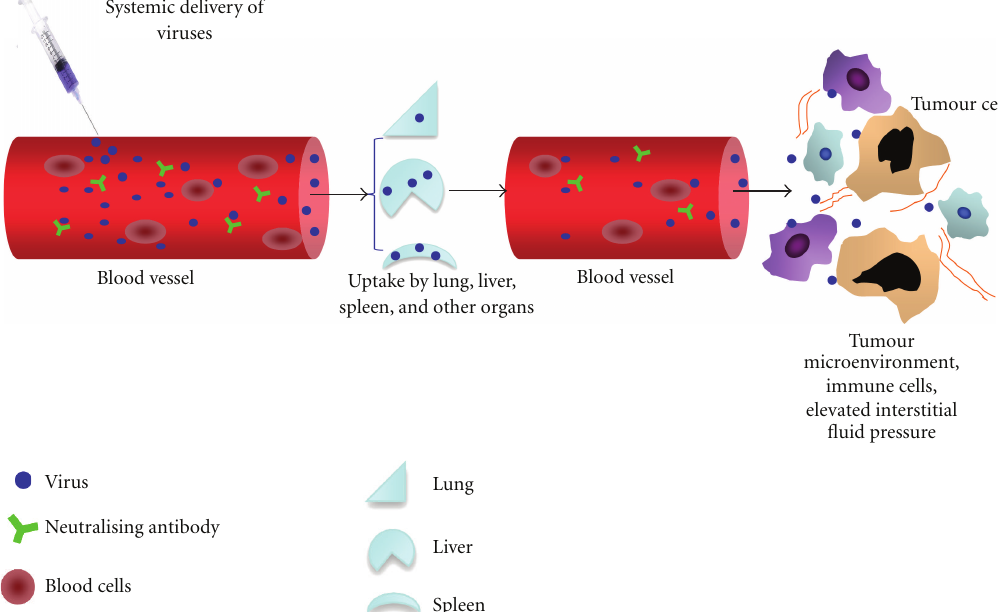
Figure 1: Hurdles of systemic delivery of oncolytic viruses to tumour cells. After intravenous injection, viruses are neutralised by pre- existing antibodies and complement activation. Oncolytic viruses also interact with blood cells. Sequestration into other organs and the reticuloendothelial system is a particular problem, often with resulting toxicities. Macrophages in the lung, liver (aka kup ff er cells), and spleen are major players to clear oncolytic viruses after systemic delivery. From the blood stream, viruses have to pass through a mixture of extracellular matrix and cells (including normal and immune cells) before reaching the tumour. The connective tissue of the tumour matrix is important in the regulation and creation of the tumour vasculature; the tumour vasculature itself and interstitial pressures are also key factors involved in the ability of the virus to penetrate the tumour